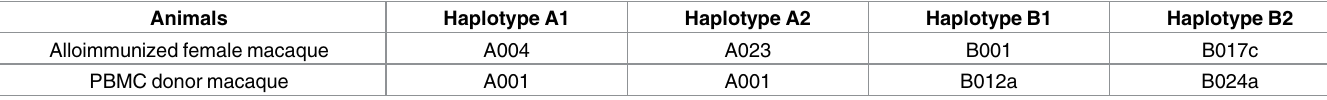
Table 1. MHC haplotypes of donor and recipient rhesus macaques. Animals